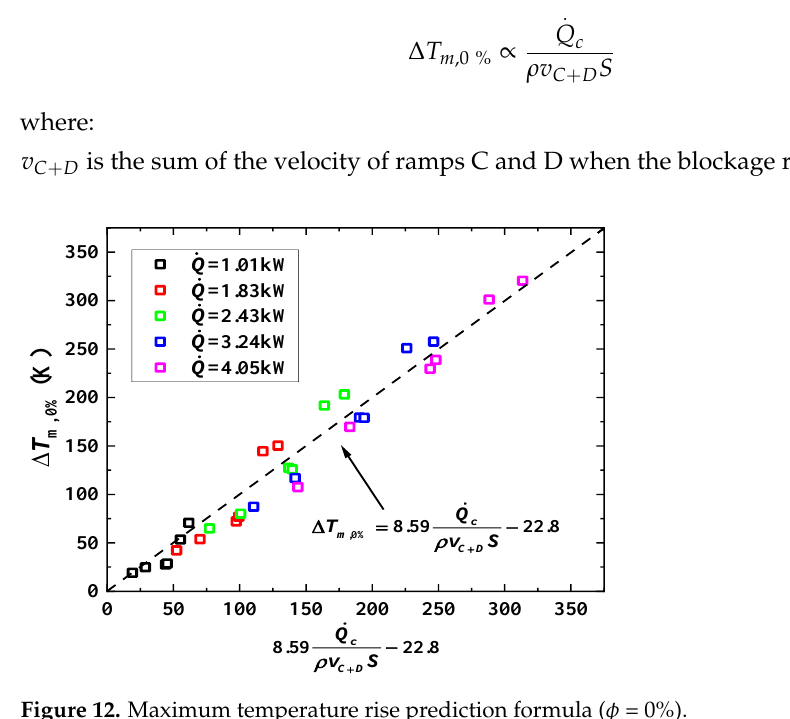
Figure 12. Maximum temperature rise prediction formula ( φ = 0%). As can be seen from Figure 12, the prediction equation at 0% blockage is shown in Equation (13), which agrees well with the experimental